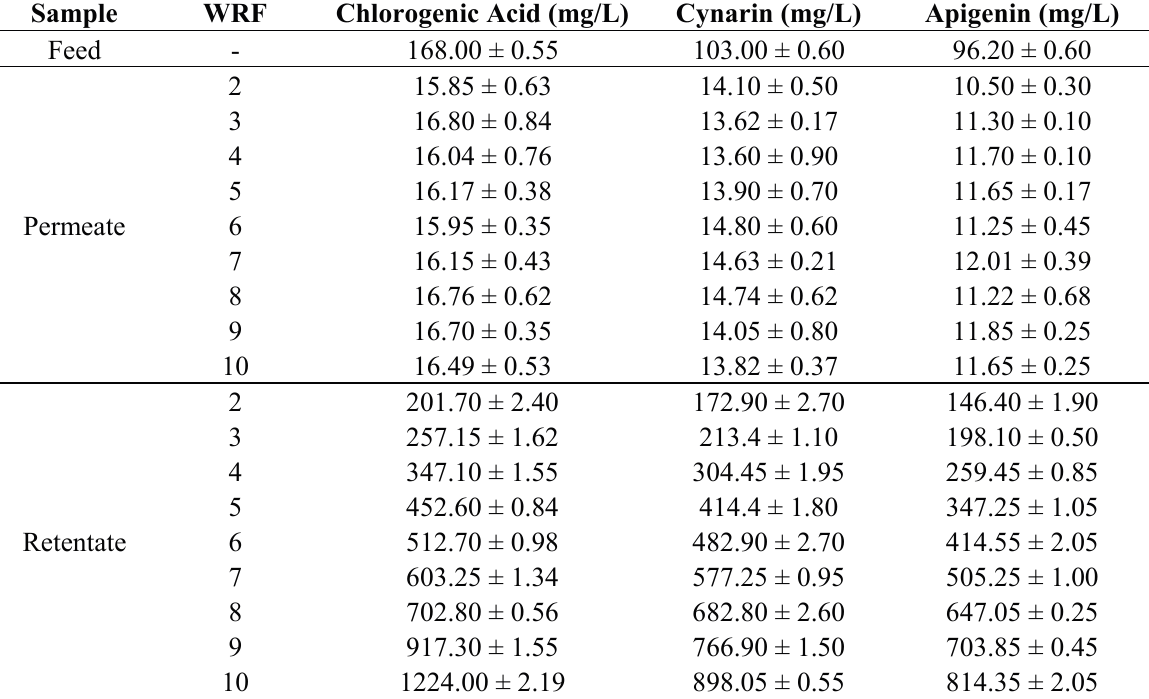
Table 2. Effect of WRF on the phenolic composition of permeate and retentate streams from clarified artichoke extract treated with NP030 membrane.